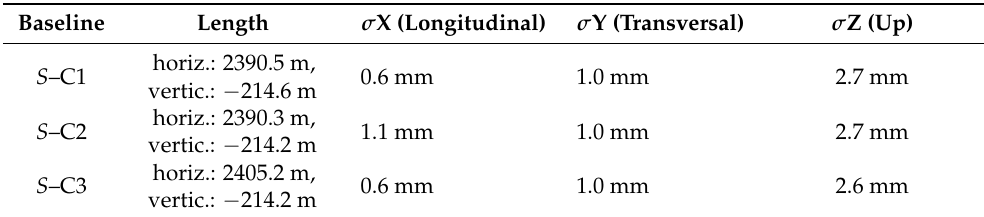
Table 4. Root mean squares (RMSs) of XYZ with respect to the mean motion (splines every 14 days) for the 3 baselines over the monitoring